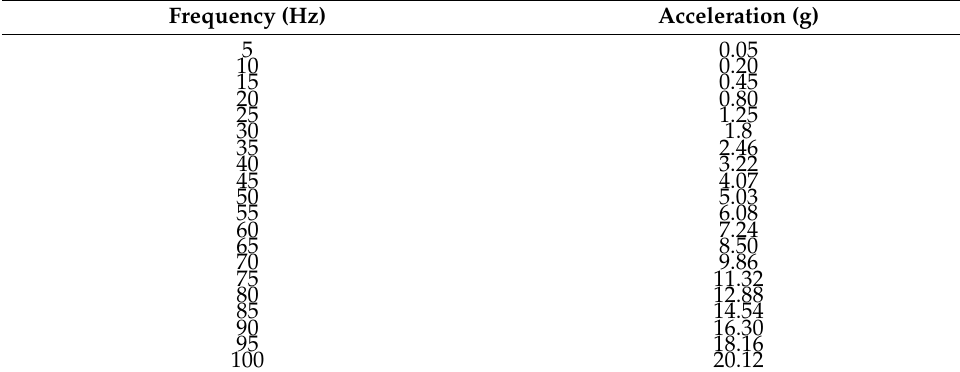
Table 9. Acceleration